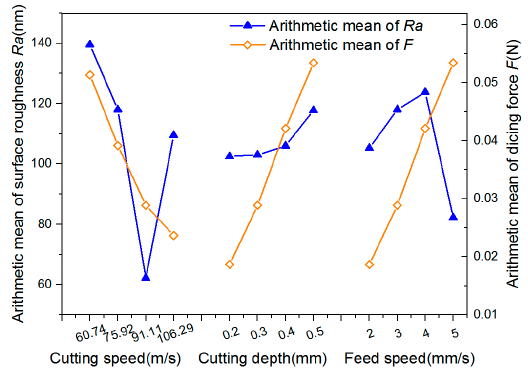
Figure 10. Influence of each level of factors on surface roughness Ra and dicing force F .